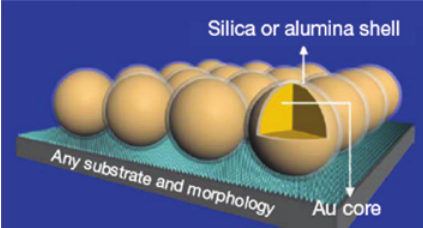
Figure 10: Simple schematic diagram covers gold nanoparticles with ultrathin alumina and silica layers.